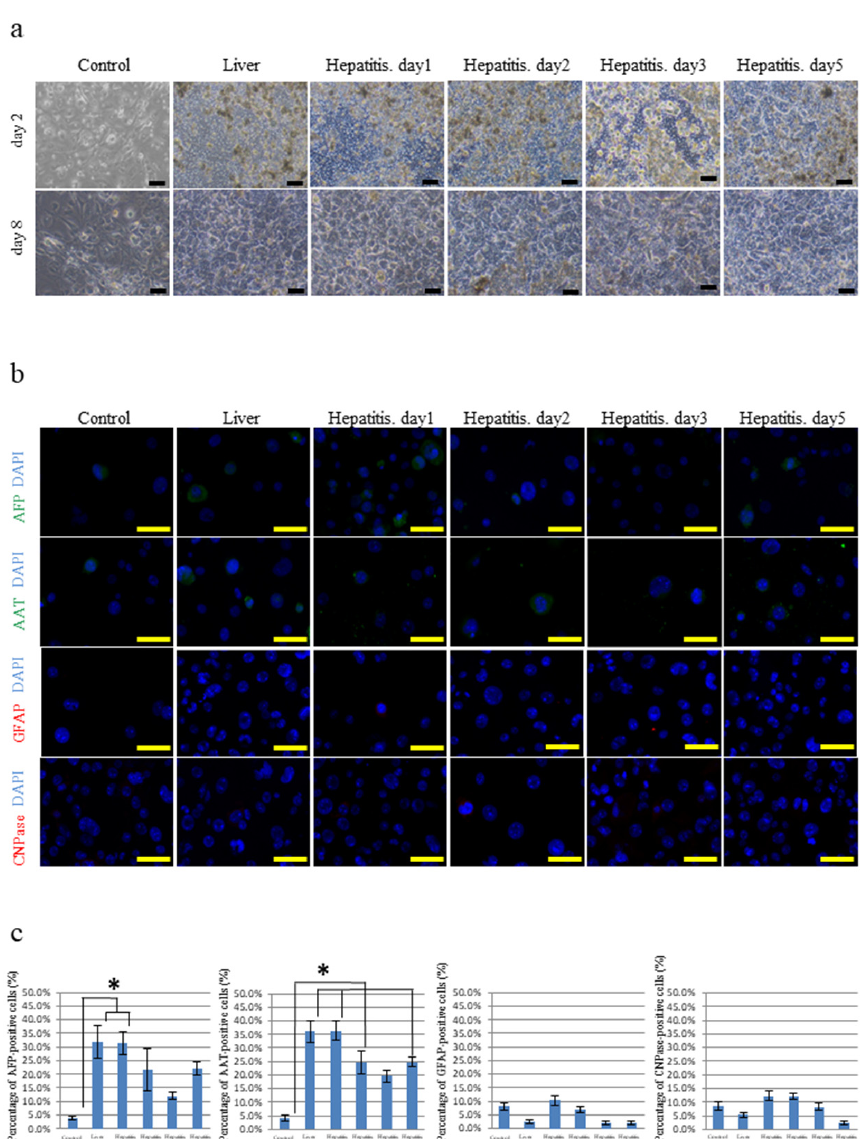
Figure 1. Analysis of a new method for inducing differentiation of iPSCs generated from the oral mucosa (hOF-iPSCs) by culturing on frozen sections of normal livers and livers with hepatitis. ( a ) Phase- contrast microscopy of the hOF-iPSCs cultured on cover glasses (as the controls) and frozen sections of normal livers or livers with hepatitis. On day 2, all the hOF-iPSCs cultured on the cover glasses and the frozen sections were loosely spread. On day 8, the hOF-iPSCs cultured on the cover glasses exhibited various morphological changes, whereas the hOF-iPSCs cultured on the frozen sections of both the normal livers and the livers with hepatitis exhibited large and polygonal morphological changes resembling hepatocytes. ( b ) Immunocytochemical analysis of hepatocyte-differentiated (AFP and AAT) and neuron-differentiated (GFAP and CNPase) markers in induced hOF-iPSCs. As a counterstain, 4 (cid:48) ,6- diamidino-2-phenylindole (DAPI) was used. AFP and AAT were efficiently expressed in the induced hOF-iPSCs cultured on the normal livers and the livers with hepatitis compared with the control hOF- iPSCs. Few neuron-differentiated markers were expressed in the hOF-iPSCs. ( c ) The percentages of AFP-, AAT-, GFAP-, and CNPase-positive hOF-iPSCs in the selected fields of interest. The hOF-iPSCs cultured on frozen sections of both types of livers exhibited higher AFP- and AAT-positive staining than the control group. No significant differences were observed between the normal liver group and the hepatitis liver group. Scale bars: 100 µ m; * p <